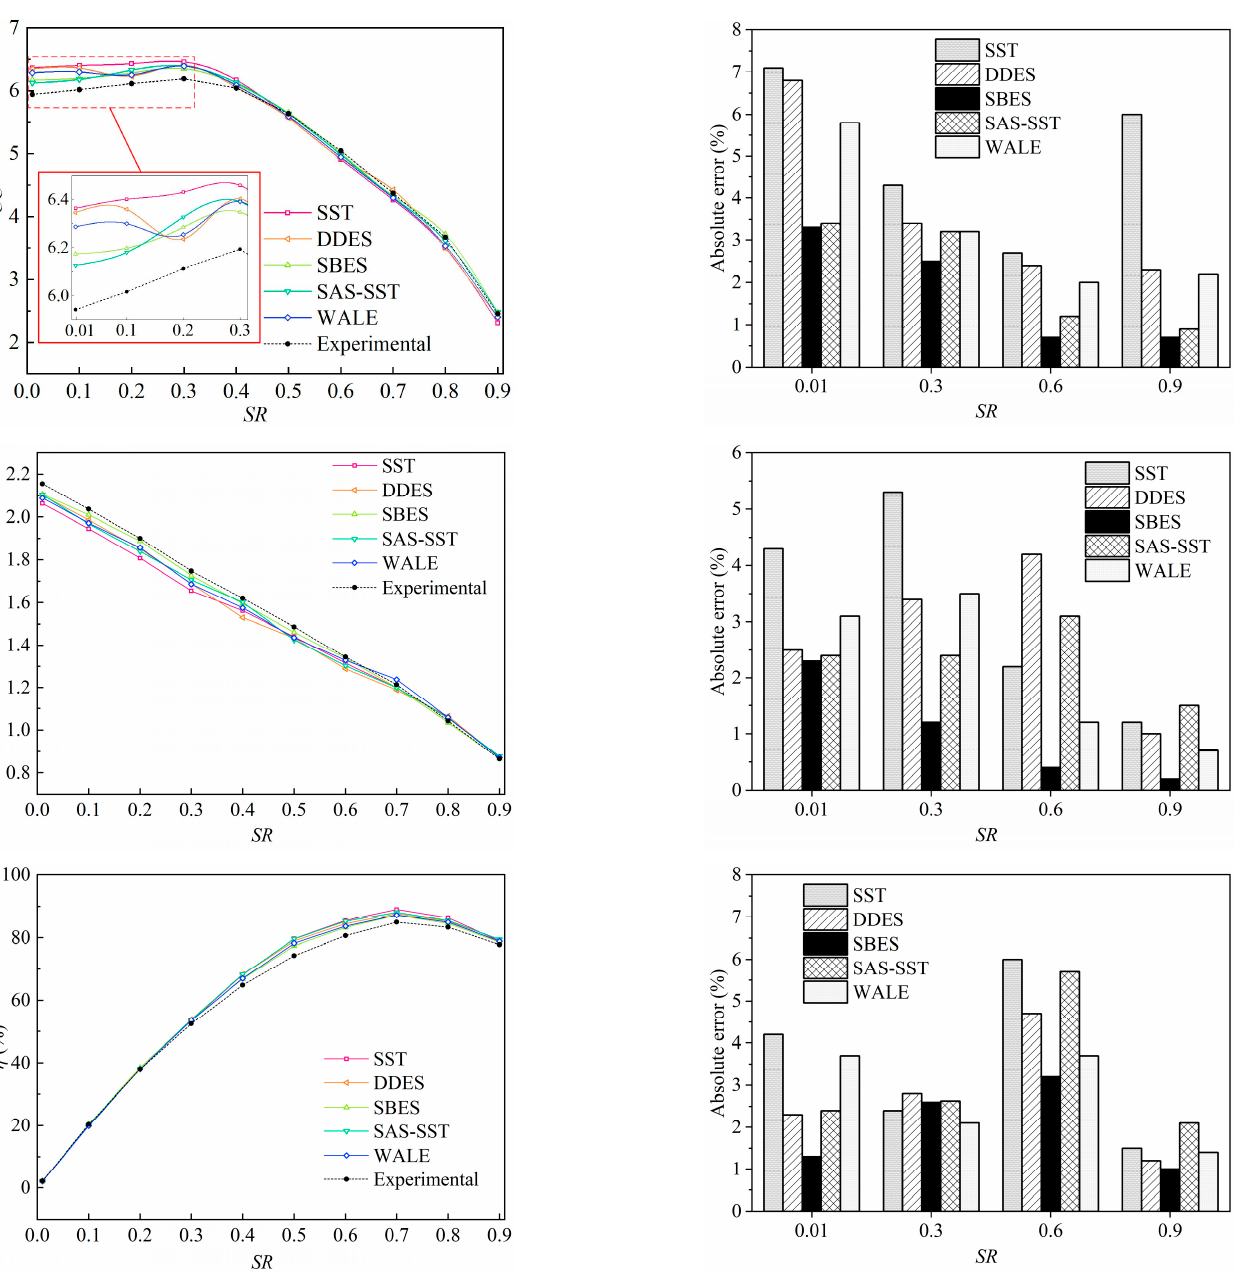
Figure 8. Comparison of simulated results and experimental data under various models.